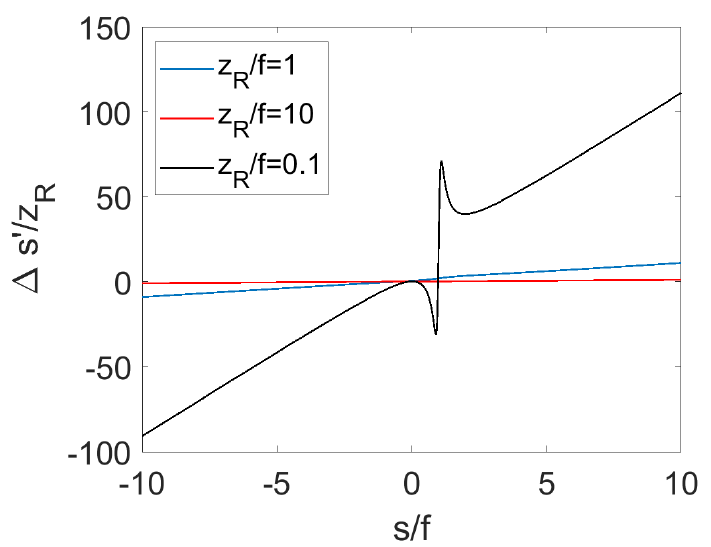
Figure 3. Plot of ∆ s (cid:48) as a function of s / f for three different z R / f values. Larger relative focal shifts z R are achieved when the focal length is larger than the Rayleigh range of the incident